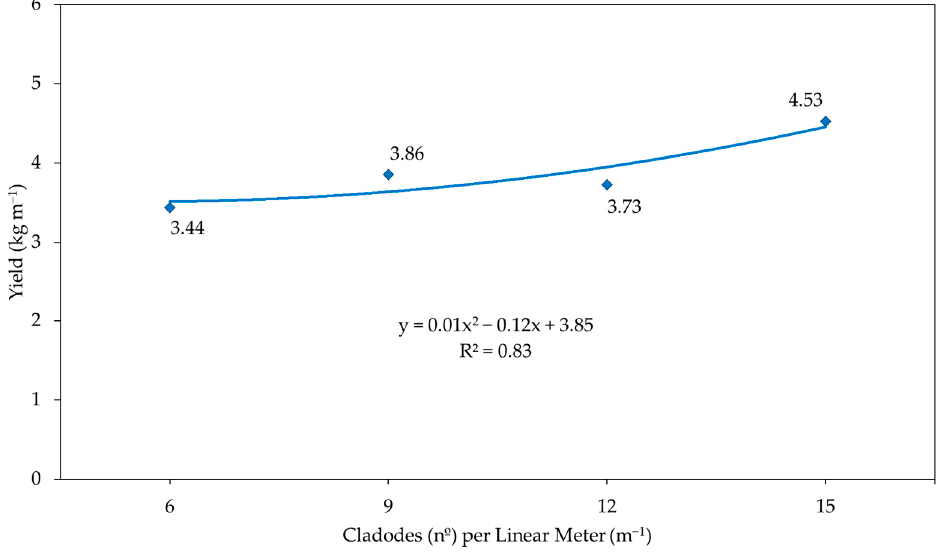
Figure 3. Yield (kg m − 1 ) in response to pruning treatments.